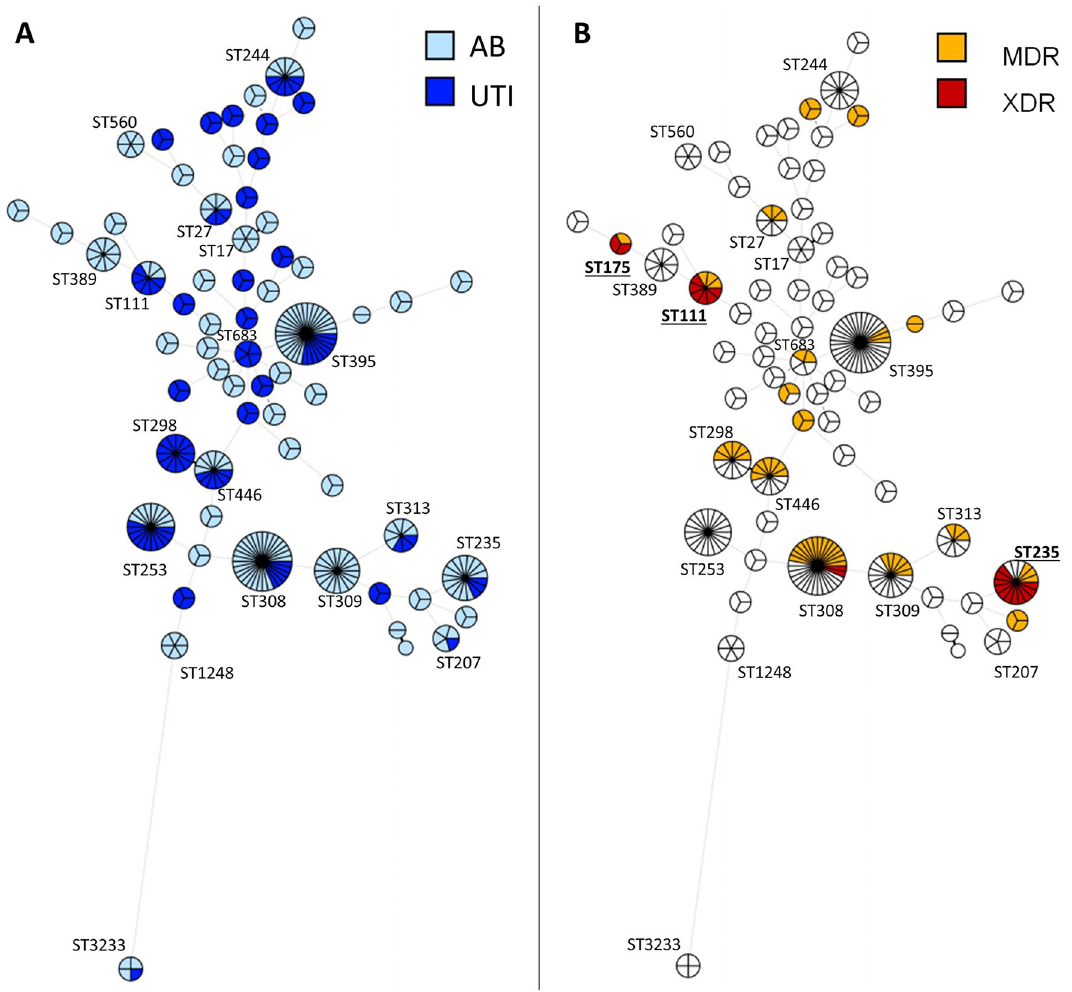
Figure 2. Minimum spanning tree of the 358 P. aeruginosa urinary isolates typed by multilocus sequence typing (MLST). The sequences were concatenated and analyzed with BioNumerics. Clustering of MLST profiles was done using a categorical coefficient. The colors used are based ( A ) on clinical contexts (AB: Asymptomatic Bacteriuria; UTI: Urinary Tract Infection) and ( B ) on antimicrobial resistance profiles (MDR: MultiDrug Resistant; XDR: eXtensively Drug Resistant). Each circle represents a sequence type (ST) and its size is proportional to the number of isolates. Length of the lines represent the genetic distance between isolates. Thick, short lines connecting two types denote types differing in a single locus; thin, longer lines connect double-locus variants; and dashed lines indicate the most likely connection between two types differing in more than two